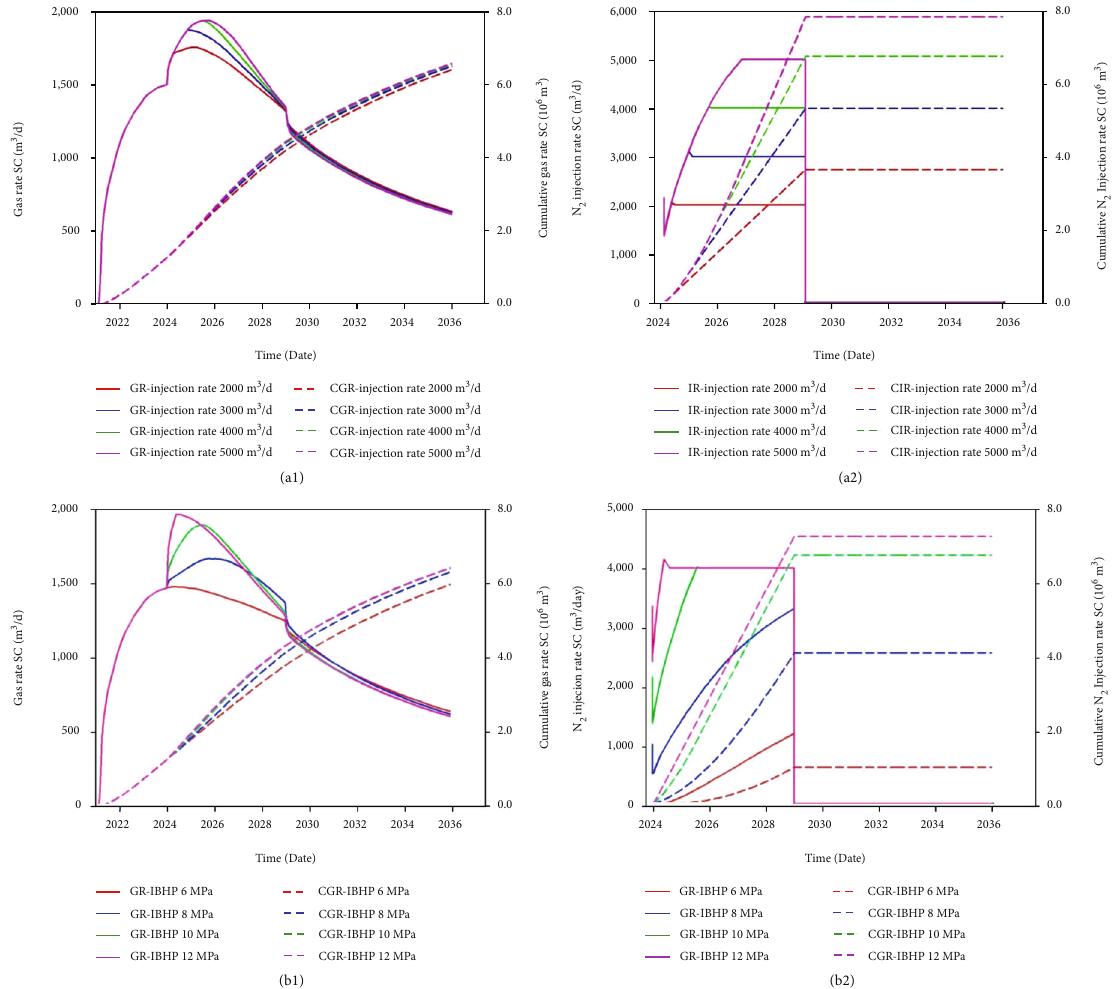
Figure 5: CBM production curves and N injection curves under di ff erent N injection production conditions: (a and c) are CBM 2 2 production curves of gas injection rate and the bottom-hole injection pressure, respectively; (b and d) are N injection curves of gas 2 injection rate and the bottom-hole injection pressure, respectively. IBHP denotes the bottom-hole injection pressure, GR refers to daily gas production, CGR denotes cumulative gas production, IR represents daily gas injection, and CIR denotes cumulative gas injection. SC denotes surface